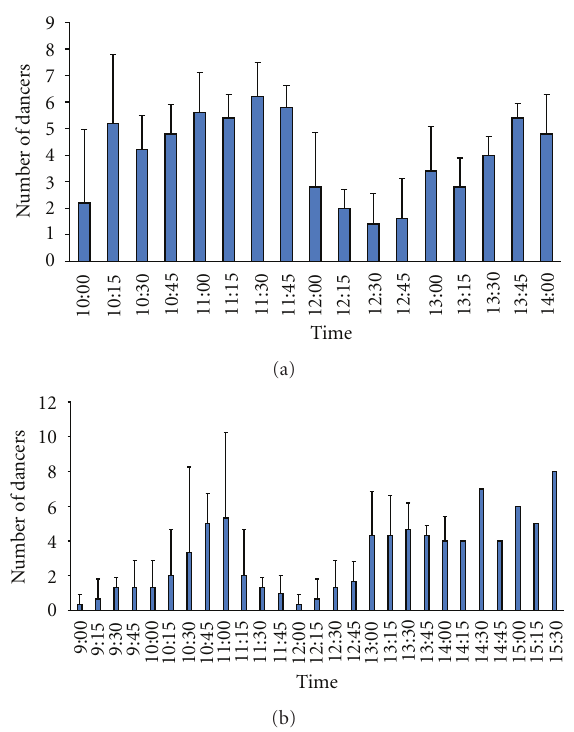
Figure 3: (a) The mean frequency distributions of the numbers of dancing bees for (a) food sources at Chom Bueng, Thailand (13.37N, 99.35E, altitude 86 m). (b) The mean frequency distribu- tions of the numbers of dancing bees for new nest sites